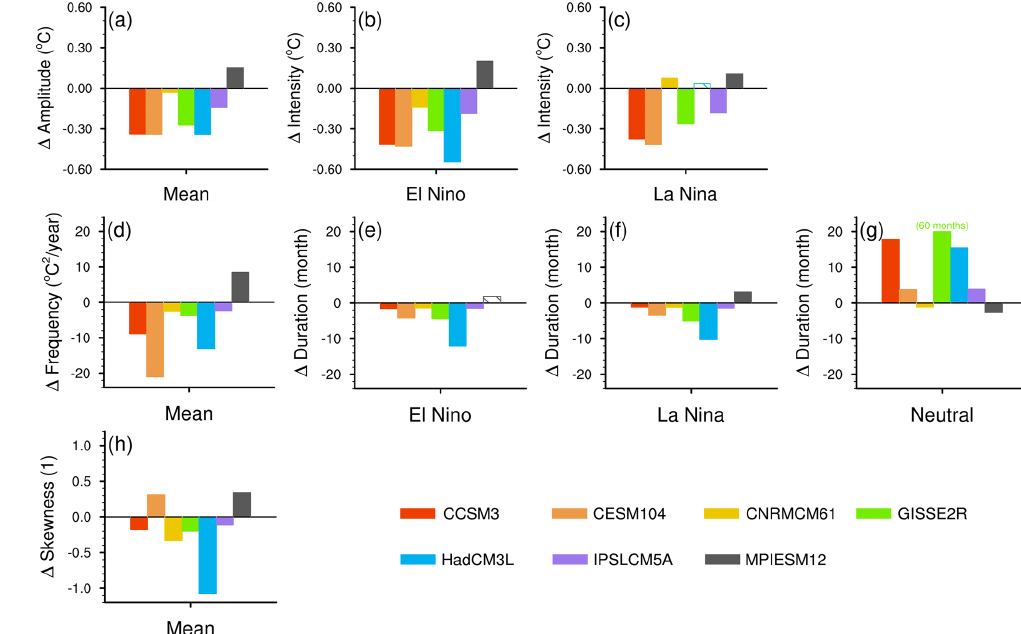
Figure 6. (a–c) Changes in abrupt4xCO 2 relative to the control in ENSO amplitude and in intensity of El Niño and La Niña states. (d– g) Changes in abrupt4xCO 2 relative to the control in ENSO frequency and in duration of El Niño, La Niña and neutral states. (h) Changes in the skewness of the Niño3.4 index distribution. Solid bars represent changes that are significant at the 5% level of a bootstrap test; hatched bars represent changes that are